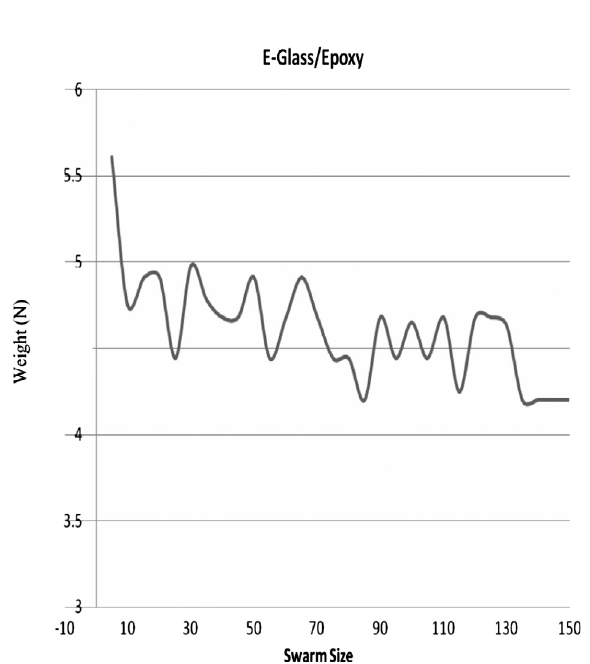
Figure 5. Variations of weight of E-Glass/Epoxy drive shafts with swarm size.